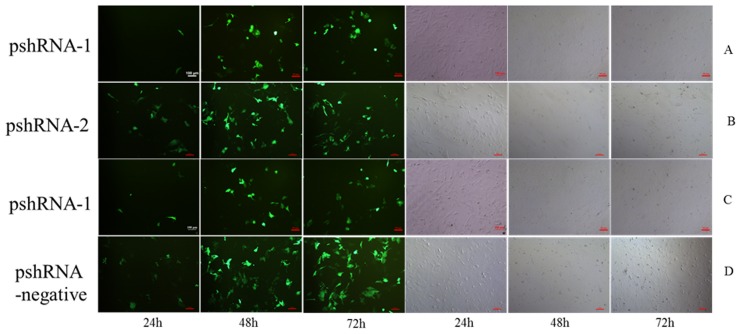
Inhα RNAi recombinant plasmids expression in the anterior pituitary cells.Three Inhα RNAi recombinant plasmids were transfected in anterior pituitary cells named as pshRNA-1, pshRNA-2, pshRNA-3 and pshRNA-negative, respectively for 24 h, 48 h or 72 h, the best efficient of which was selected for further investigation.